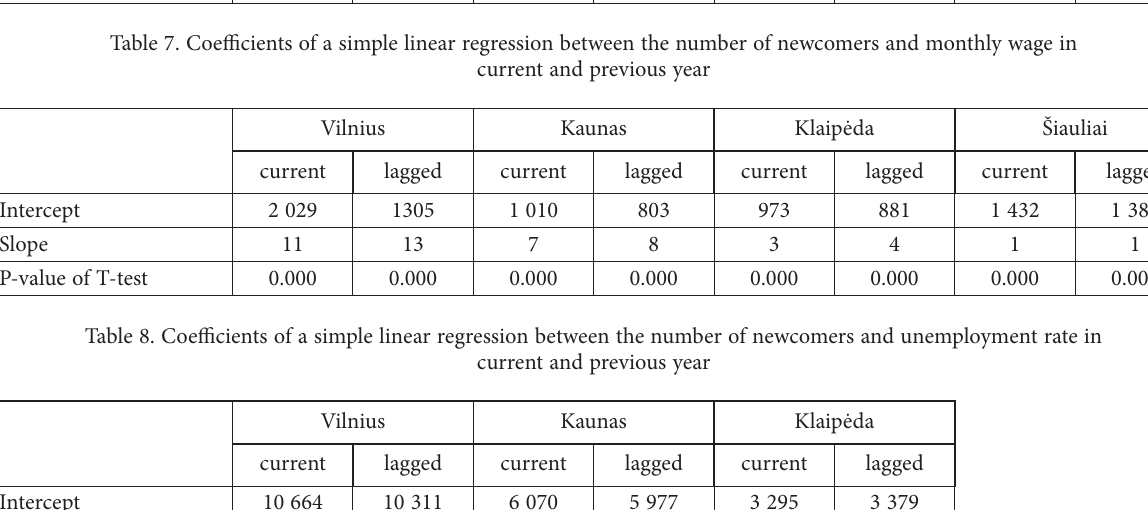
P-value of T-test Table 7. Coefficients of a simple linear regression between the number of newcomers and monthly wage in